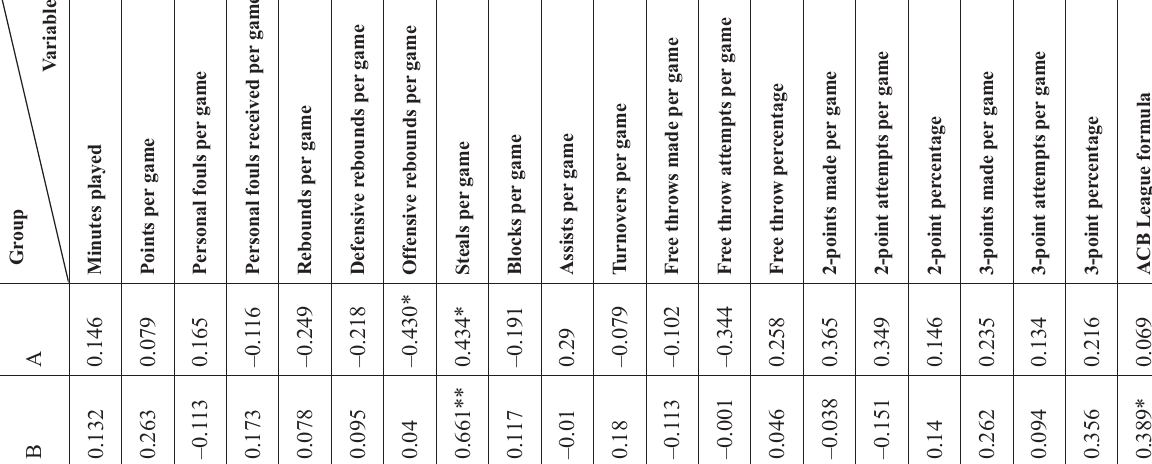
Table 2. Correlations between VO 2 max and basketball performance assessed according to competitive